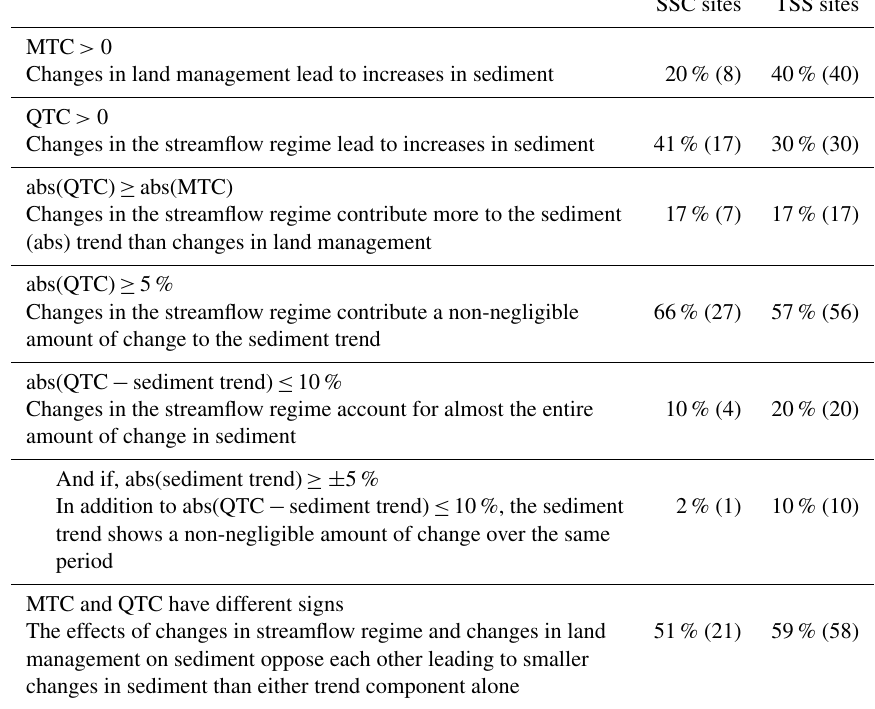
Table 3. Percent and number of sites with SSC and TSS trends for various combinations of QTC (sediment changes due to changes in the streamflow regime) and MTC (sediment changes due to changes in land management). Recall the sediment trend is equal to MTC + QTC. “abs” refers to